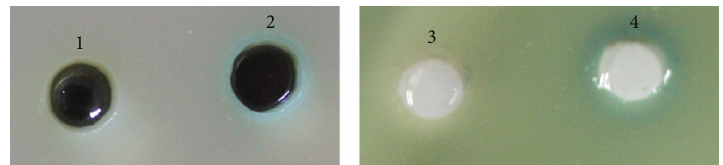
Figure 7: Measurement of the expressed B3-LAAO activity using Prussian blue agar assay [16]. Lane 1: E. coli BL21(DE3)/pET28b(+)- lao without induction; lane 2: E. coli BL21(DE3)/pET28b(+)- lao with a 6 h-induction; lane 3: E. coli BL21(DE3)/pET20b(+)- lao without induction; lane 4: E. coli BL21(DE3)/pET20b(+)- lao with a